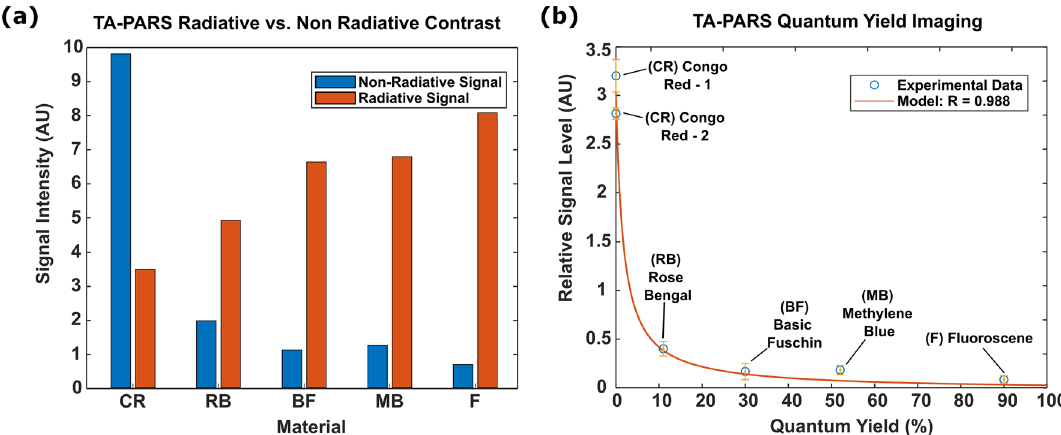
Figure 6. TA-PARS quantum efficiency ratio (QER) measurement results. ( a ) PARS radiative vs non-radiative signal magnitude in a series of samples with varying Quantum Yields. ( b ) Measured QER from the TA-PARS signals, compared to the expected